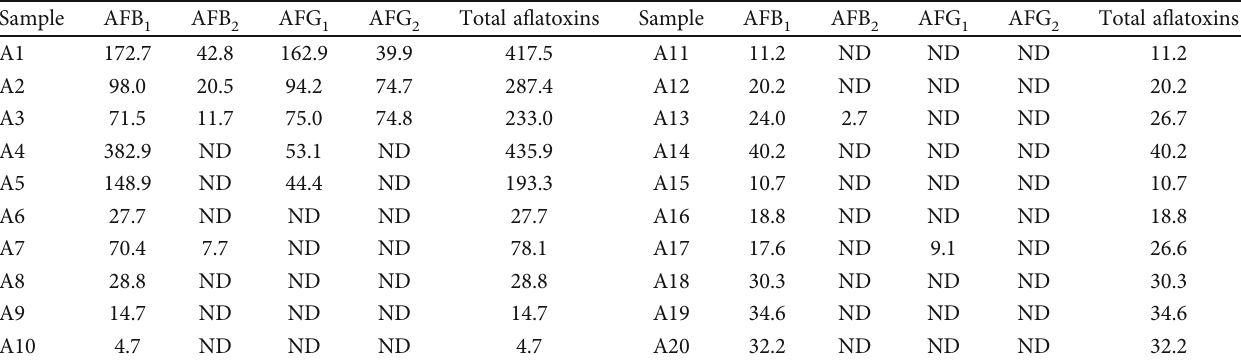
Table 3: A fl atoxin contamination levels in peanut butter produced in Mbare backyard industry ( μ g/kg). Sample AFB